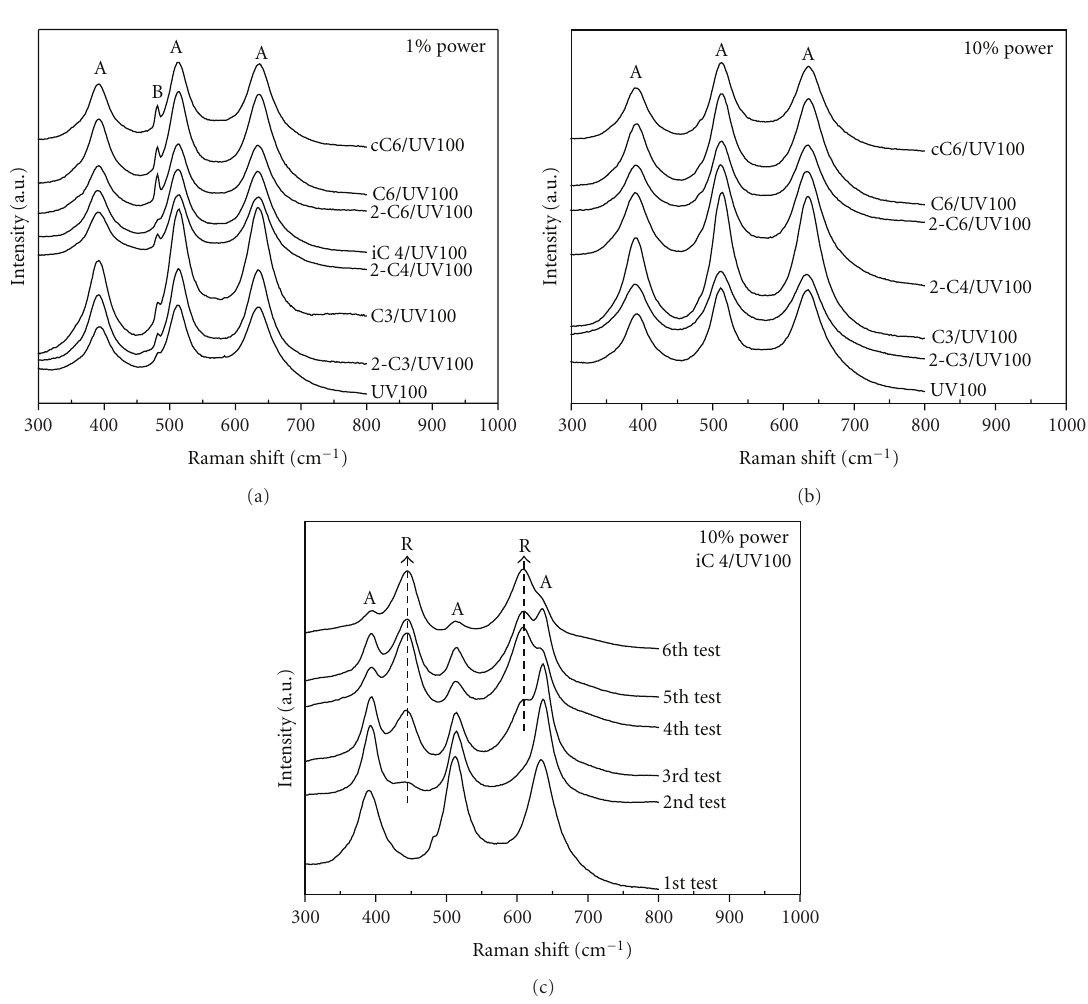
Figure 6: Raman spectra with 1% (a) and 10% (b) power for all samples; 10% power for iC4/UV100 over 6 times of test (c).